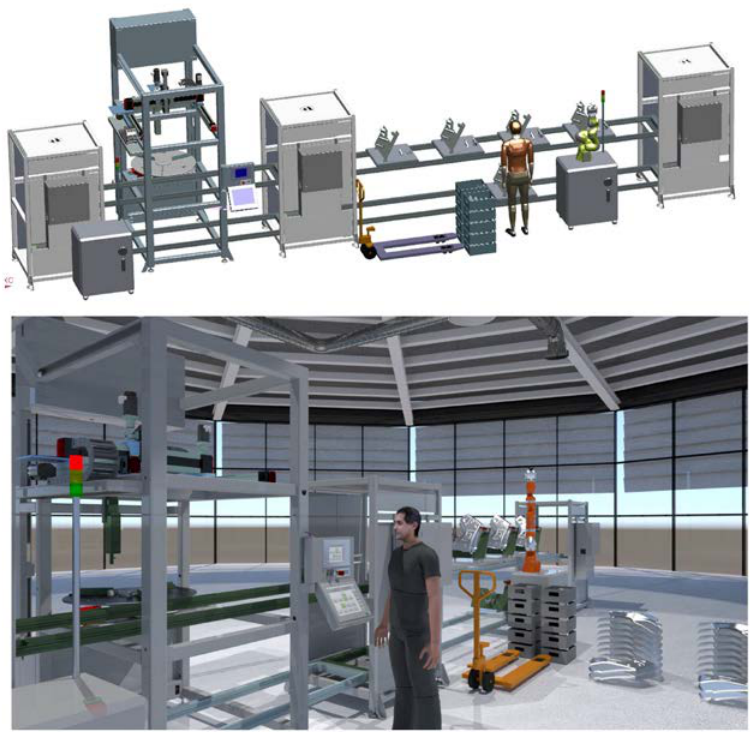
Figure 9. CAD design data and realistic visualization in VR.